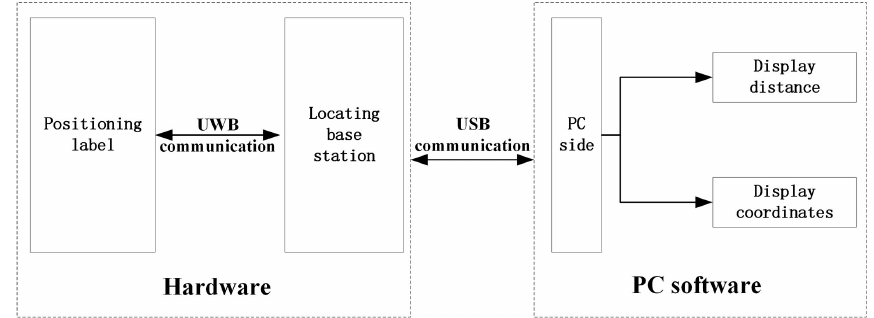
Figure 1. General block diagram of the positioning system.